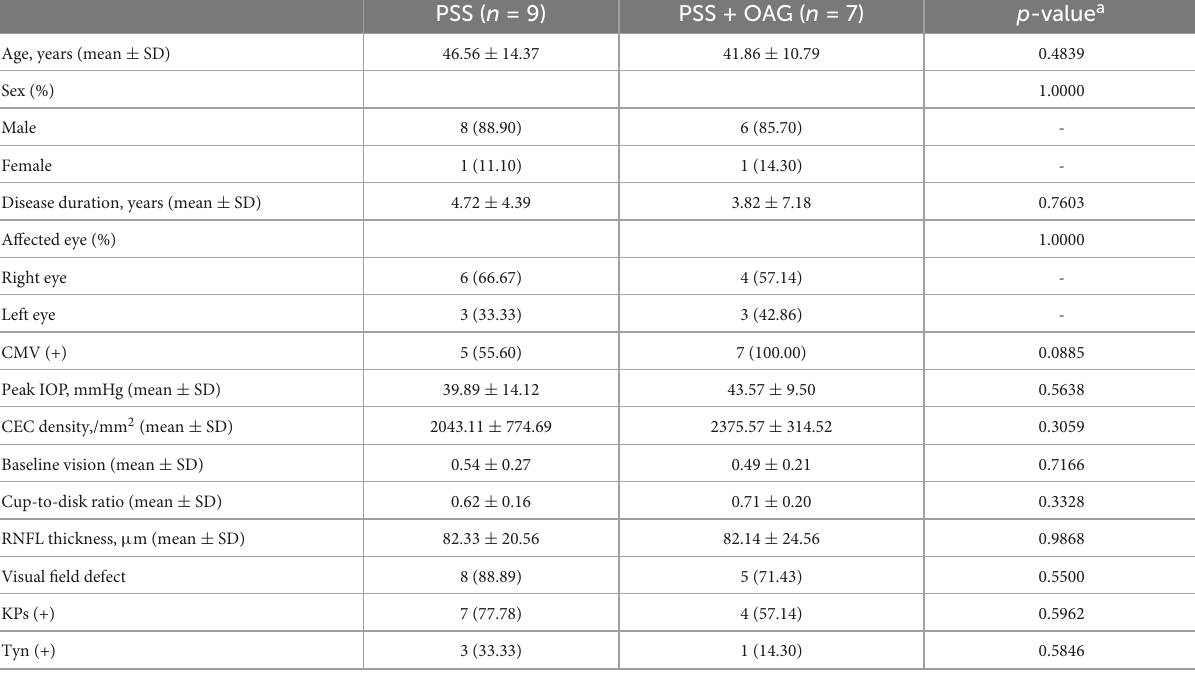
TABLE 1 Demographic and clinical data of all